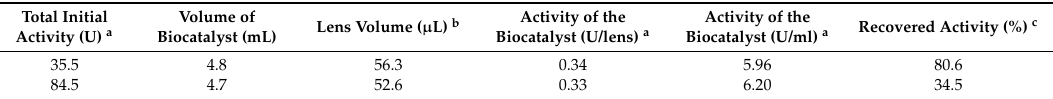
Figure 2. Operational stability of entrapped pXd-INV in PVA. Conditions for each cycle: 100 mg/mL sucrose, 50 °C, 20 min reaction.